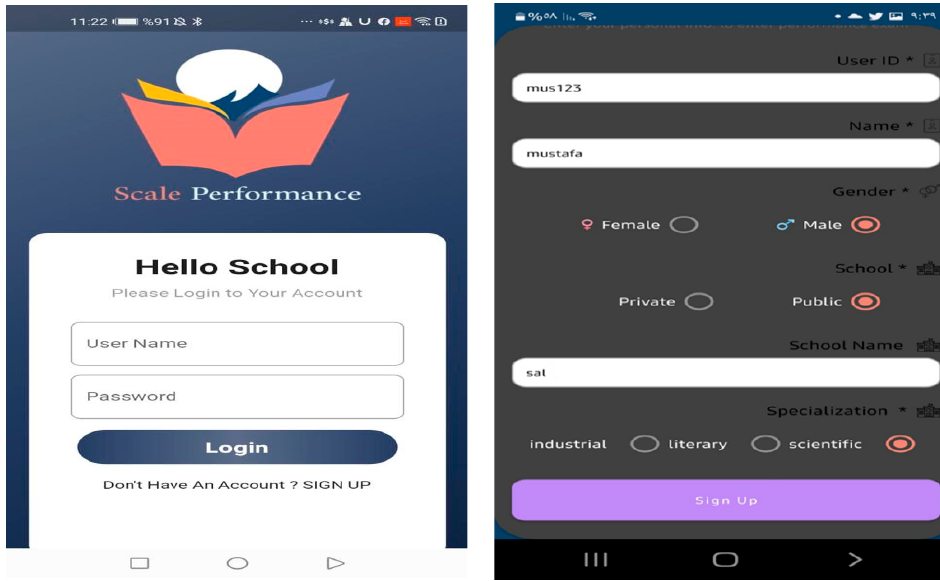
Figure 4. The first screen, login and sign-up screen, in the performance scale application.